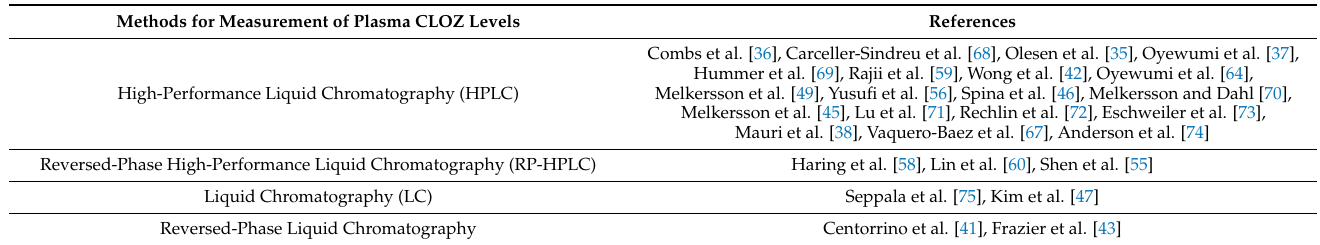
Table 1. Methods of plasma clozapine